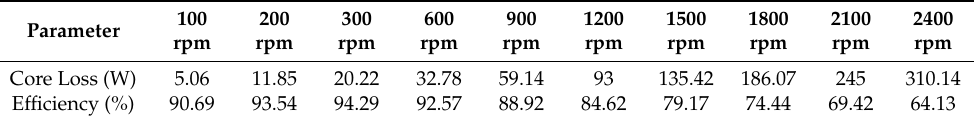
Table 5. Wide-Speed Performance of PMVM.